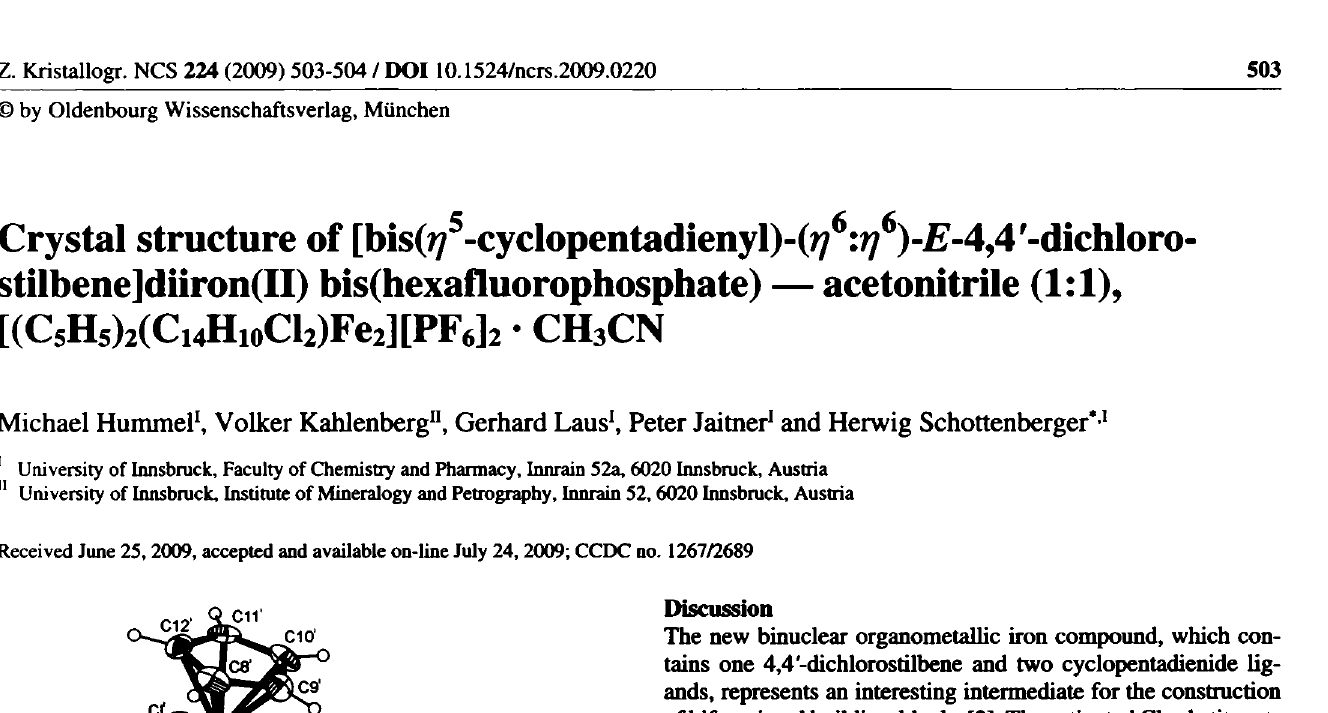
Table 1. Data collection and handling.